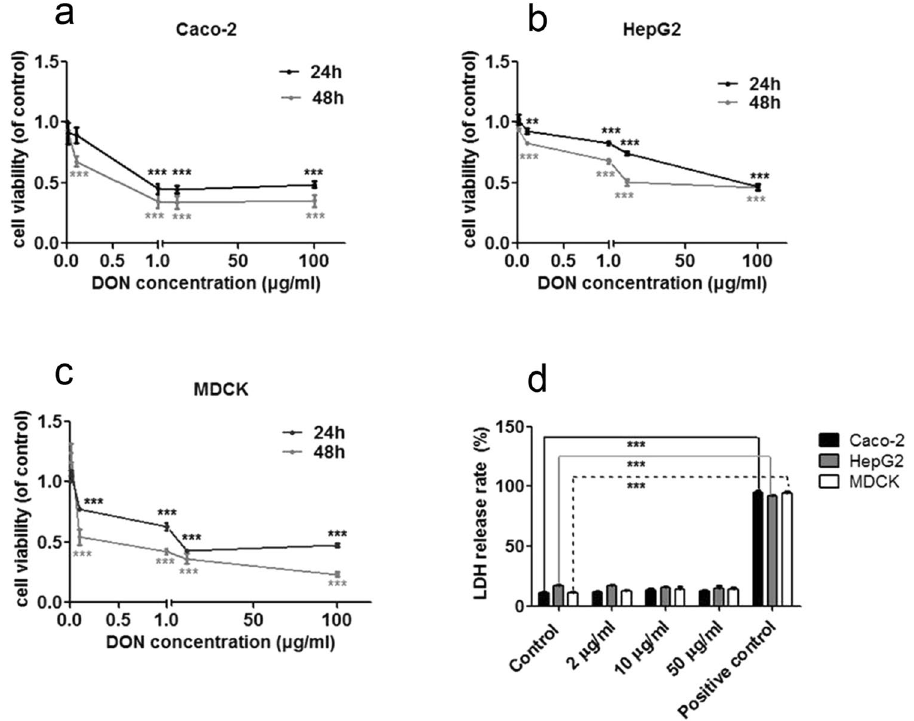
Figure 1. Cytotoxicity of DON toward Caco-2, HepG2 and MDCK cells was measured using the MTT assay and LDH assay. ( a , b and c ) The viability of Caco-2, HepG2 and MDCK cells was measured using the MTT assay after exposure to different concentrations of DON (0.01, 0.1, 1, 10, 100 μ g/ml). ( d ) Rate of LDH release by Caco- 2, HepG2 and MDCK cells exposed to 2 μ g/ml to 50 μ g/ml DON for 24 h. Nine percent Triton X-100 was used as the positive control. The data are presented as the mean values ± standard deviations (SD) (n = 5). Significant differences between the positive control and control group are indicated by ** P < 0.01 and *** P <